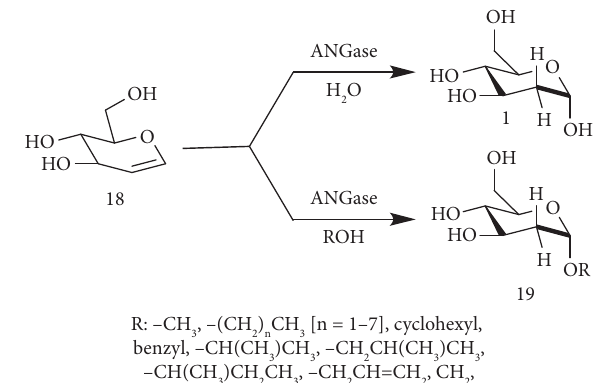
Figure 8: Synthesis of D-arabo-2-desoxyhexose from ribose.